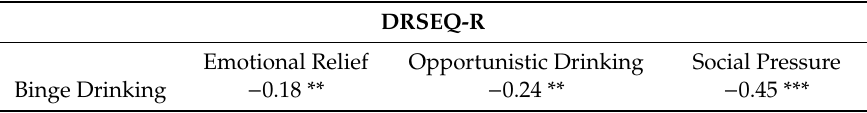
Table 3. Correlation between binge drinking and DRSEQ-R.